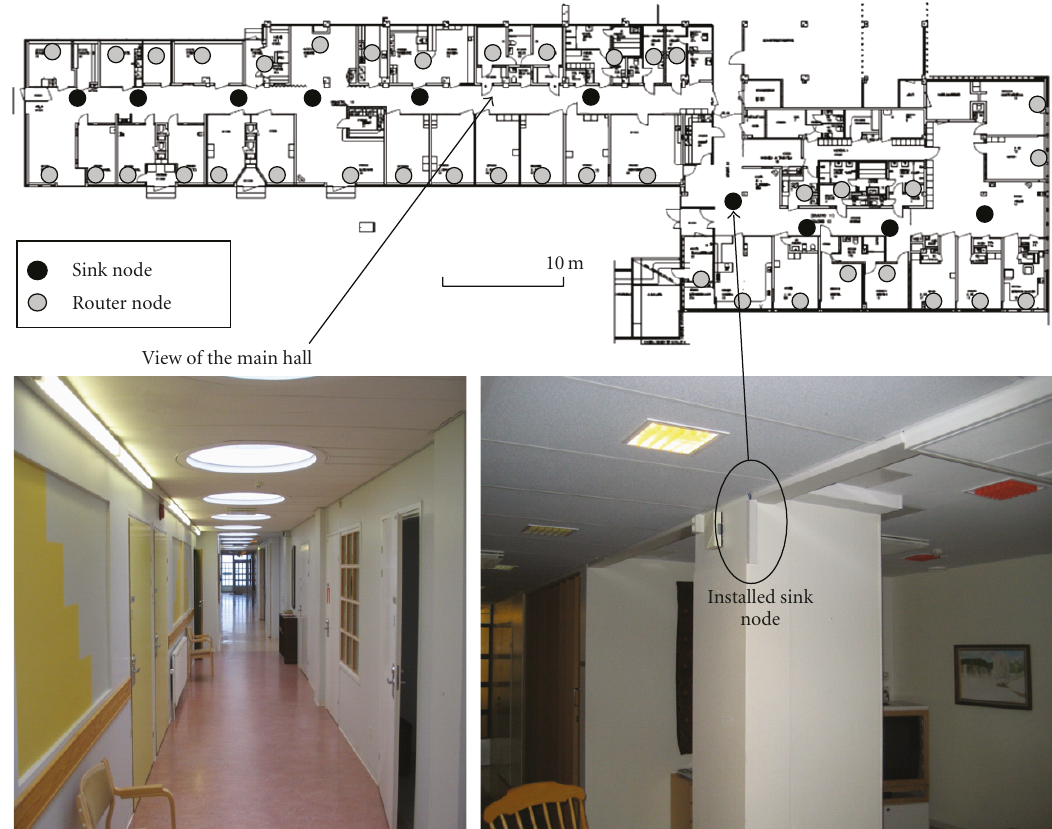
Figure 16: Network deployment at the hospital unit. The deployment includes 9 sink nodes, 41 router nodes, and 12 mobile nodes.